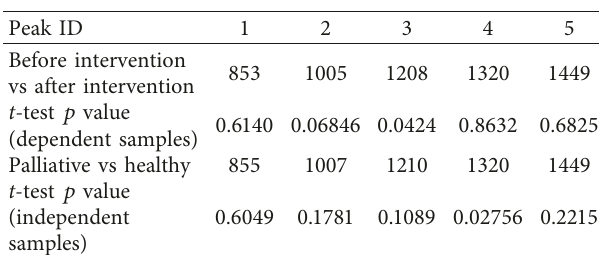
Table 2: Identified peaks.